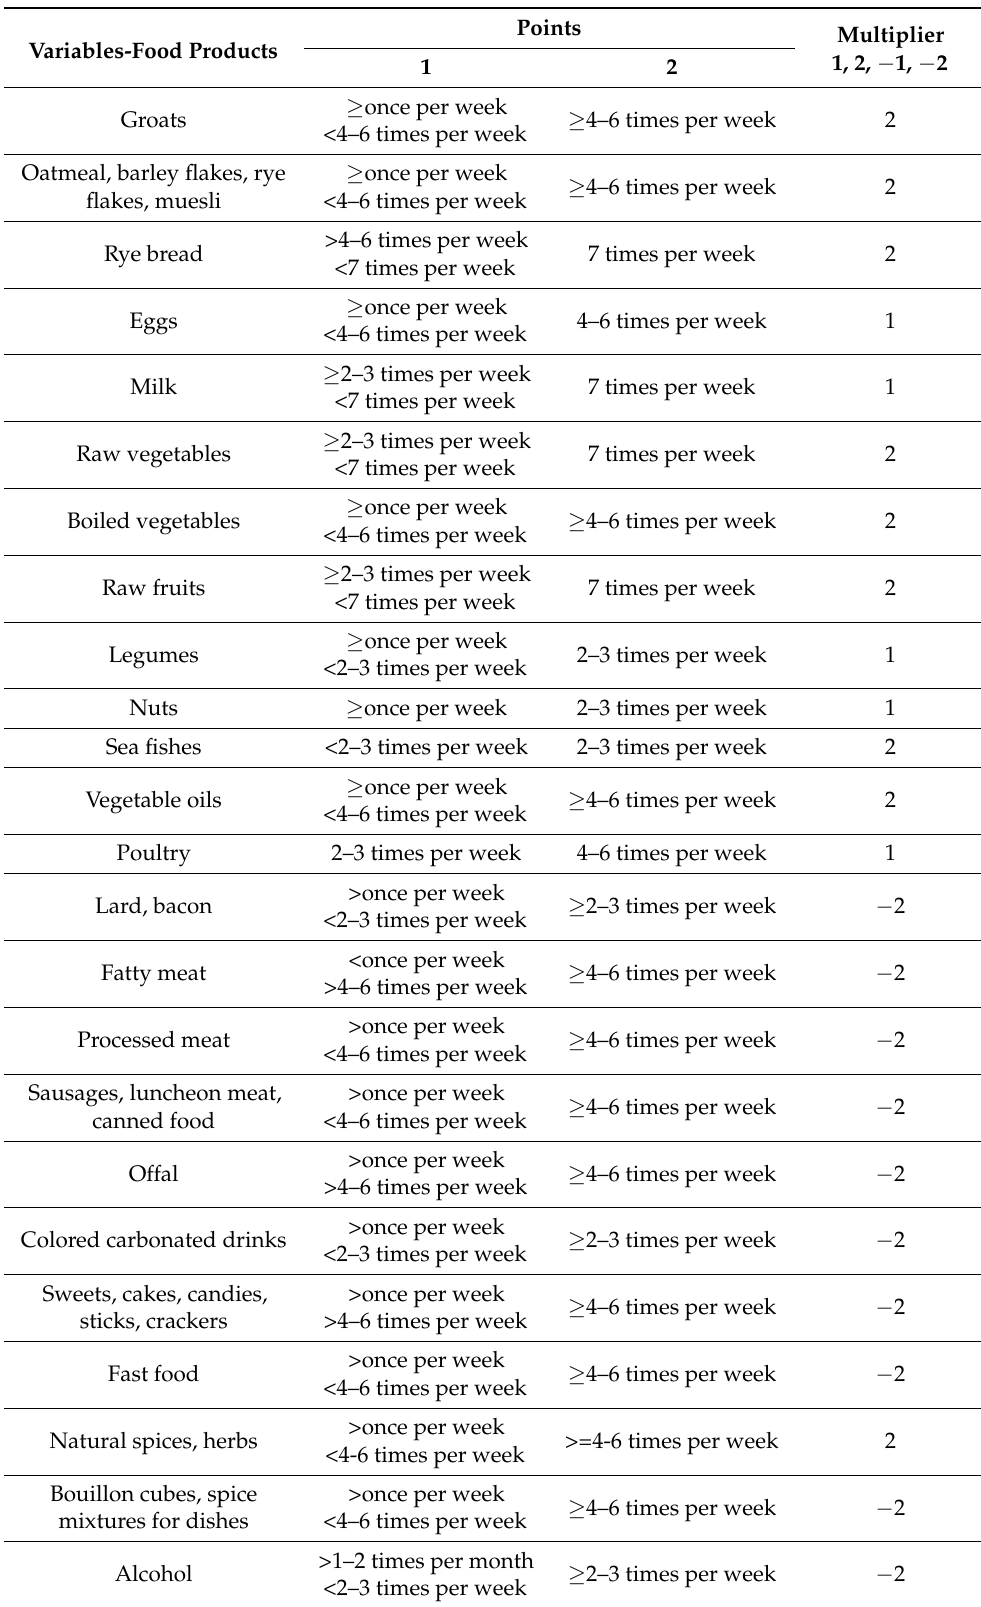
Table 1. Scoring of the consumption of selected products in the study population. Variables-Food